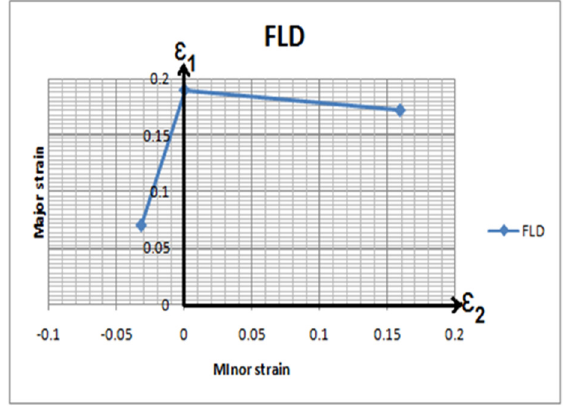
Fig. 6. Forming limit diagram for AL1050 aluminum alloy.